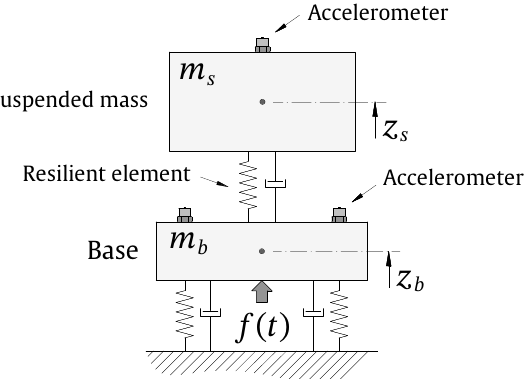
Figure 1. 2DOF model of the laboratory test setup adopted. The big arrow represents the dynamic force applied by the